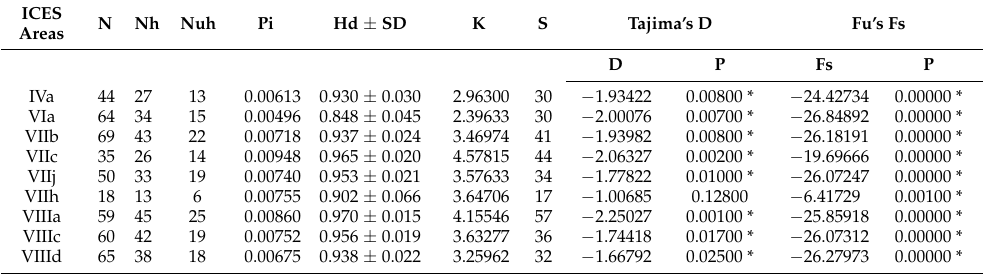
Figure 2. Median-joining haplotype network of A. simplex mtDNA cox2 sequences obtained from European hake from 10 ICES division areas. Circles’ size represents the frequency of each haplotype. Hatch marks show the number of mutations distinguishing the haplotypes. Majority haplotypes (including more than 10 sequences) are reported. Black points indicate missing haplotypes. Table 3. Genetic diversity indices and neutrality test based on mtDNA cox2 sequences of A. simplex parasitizing European hakes from ten ICES divisions.